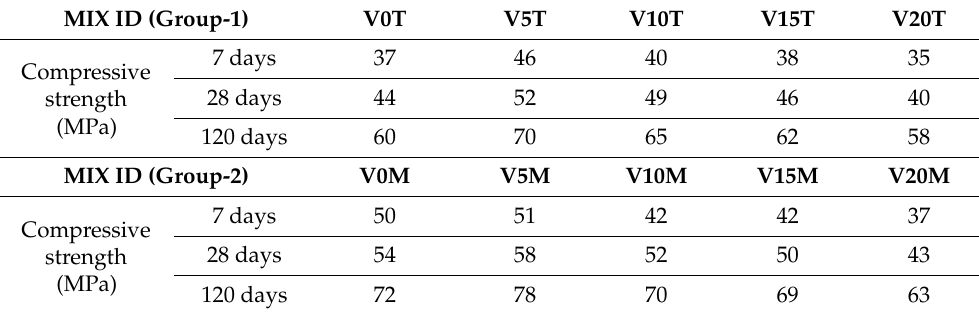
Table 8. Compressive strength values of volcanic concrete.